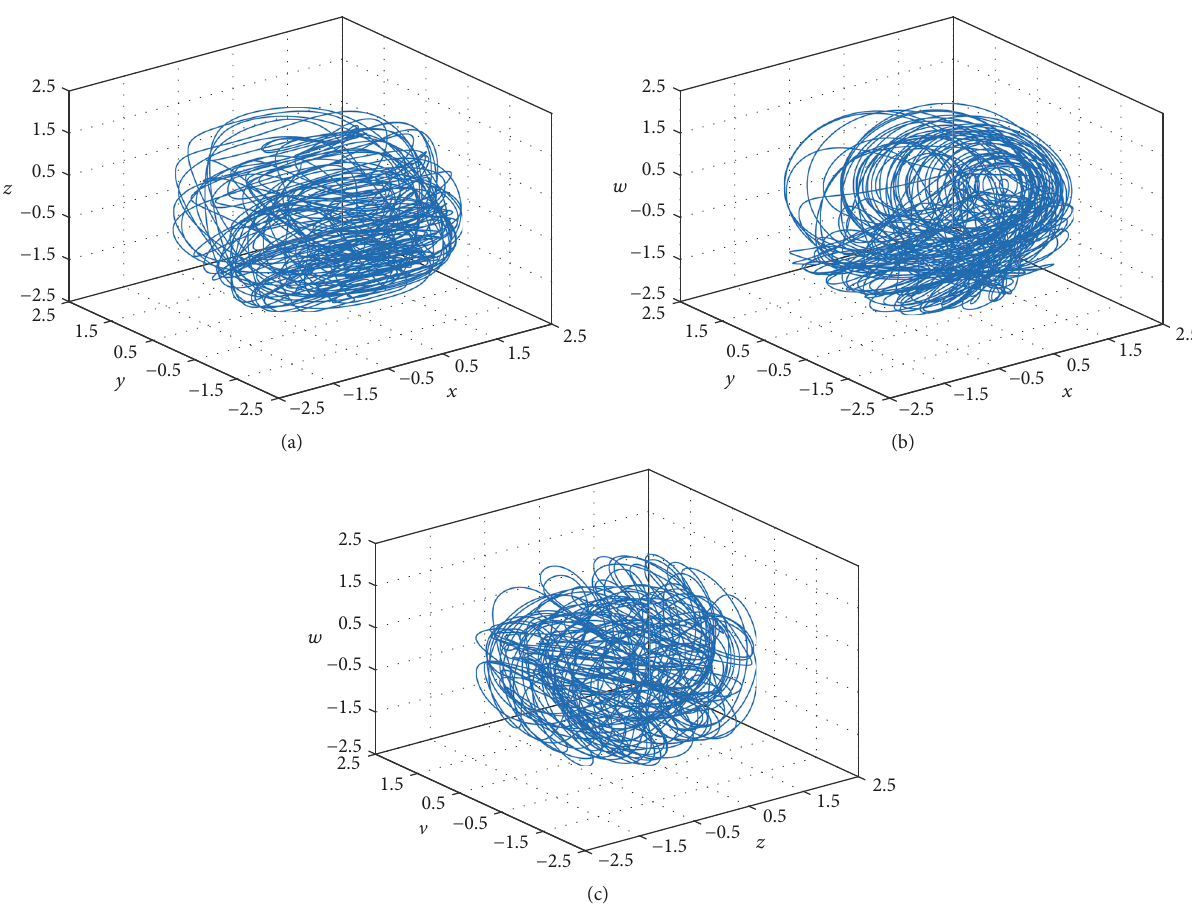
Figure 3: Phase portraits of the system (2) with parameters 𝑎 = 1 , 𝑏 = 1 , and the initial conditions (𝑥 0 ,𝑦 0 ,𝑧 0 , V 0 , 𝑤 0 ) = (1, 1, 1, 1, 1) : (a) 𝑥 − 𝑦 − 𝑧 space; (b) 𝑥 − 𝑦 − 𝑤 space; (c) 𝑧 − V − 𝑤